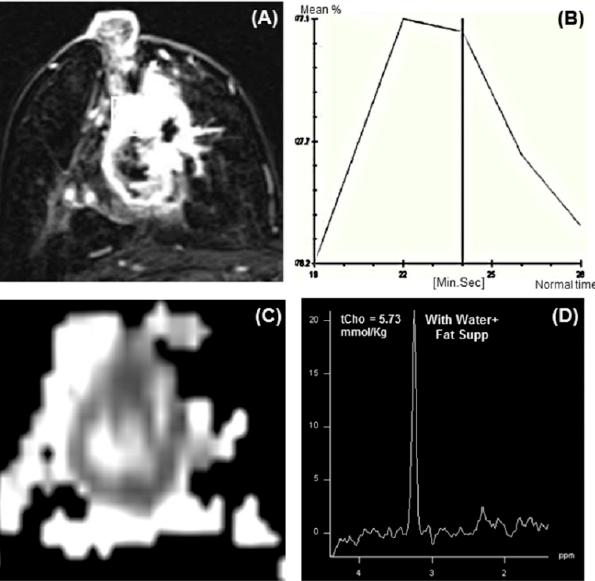
Figure 6. ( A ) Representative DCE-MR image of a 56-year-old locally advanced breast cancer patient suffering from IDC, and ( B ) the corresponding type III curve obtained from the ROI positioned on the lesion. ( C ) shows the ADC map while ( D ) is the in vivo 1 H MR spectrum of the same patient (Reproduced with permission from Elsevier from Reference [144]).